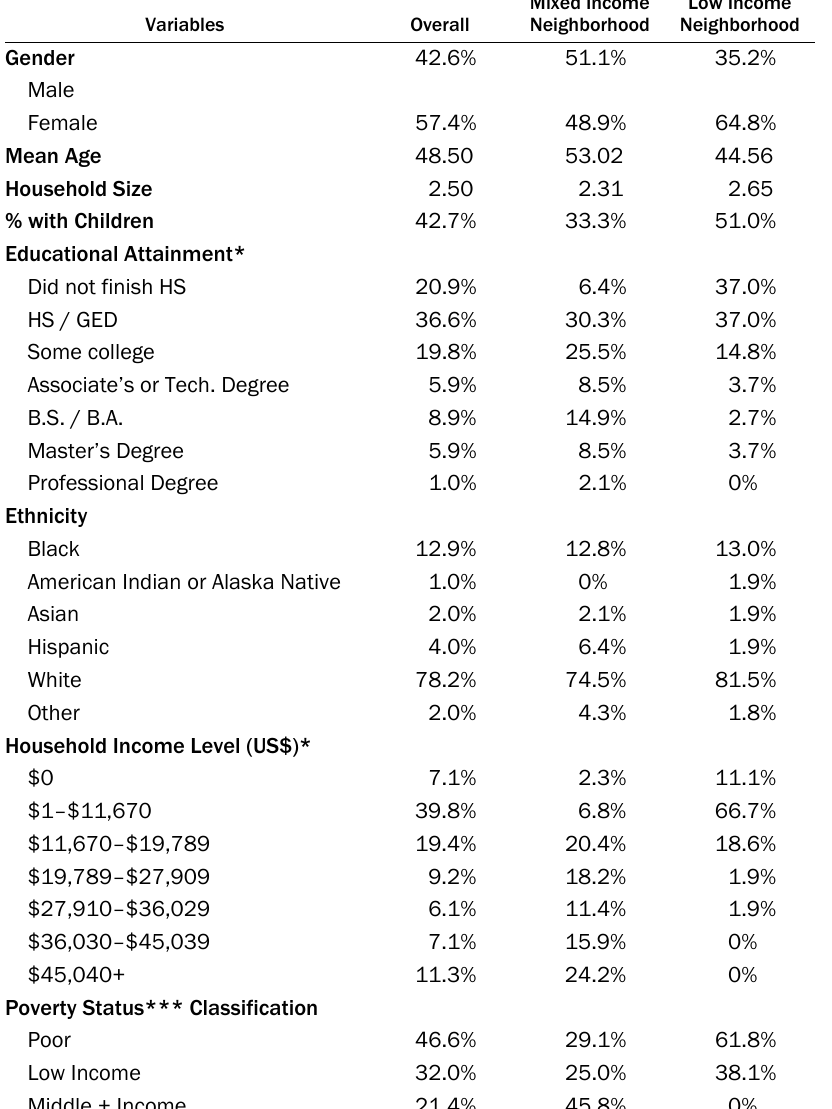
Table 1. Demographic Results and Comparison Between Neighborhood